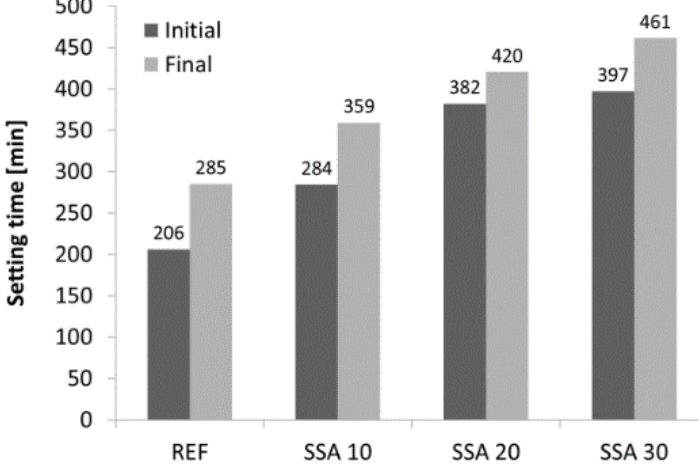
Figure 4. Setting time of cement binders with SSA content.